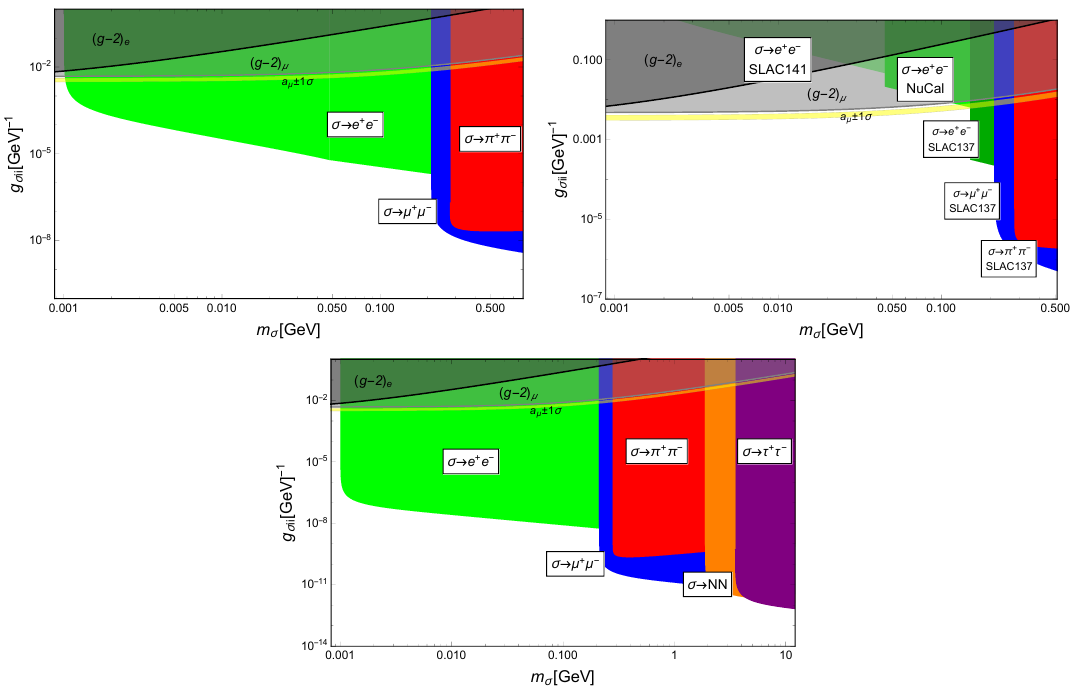
Figure 9. (Top Left) The region in g (cid:27)ii (cid:0) m (cid:27) parameter space where the SN 1987a bounds are a(cid:11)ected by the radion decay to e (cid:0) e (cid:0) ; (cid:22) + (cid:22) (cid:0) , and (cid:25) + (cid:25) (cid:0) . Here we have assumed the SN has an e(cid:11)ective radius of 15 km and a temperature of 30 MeV. (Top Right) The regions where bounds from beam dump experiments are a(cid:11)ected by radion decay. (Bottom) The region where the constraints from cosmological bounds are eliminated. We take the upper limit on the radion lifetime for decays to e ’s and (cid:22) ’s to be 10 s, and for decays to (cid:25) ’s, (cid:28) ’s and nucleons to be 1 s [34]. (All) The gray(black) regions show the excluded region from g (cid:0) 2 experiments for the muon(electron). The exclusion regions from g (cid:27)ee and g (cid:27)(cid:22)(cid:22) are set at 99% con(cid:12)dence level, and the (cid:6) 1 (cid:27) (cid:13)avored band for a (cid:22) is shown as a yellow